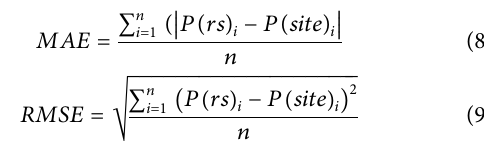
Frontiers in Environmental Science |